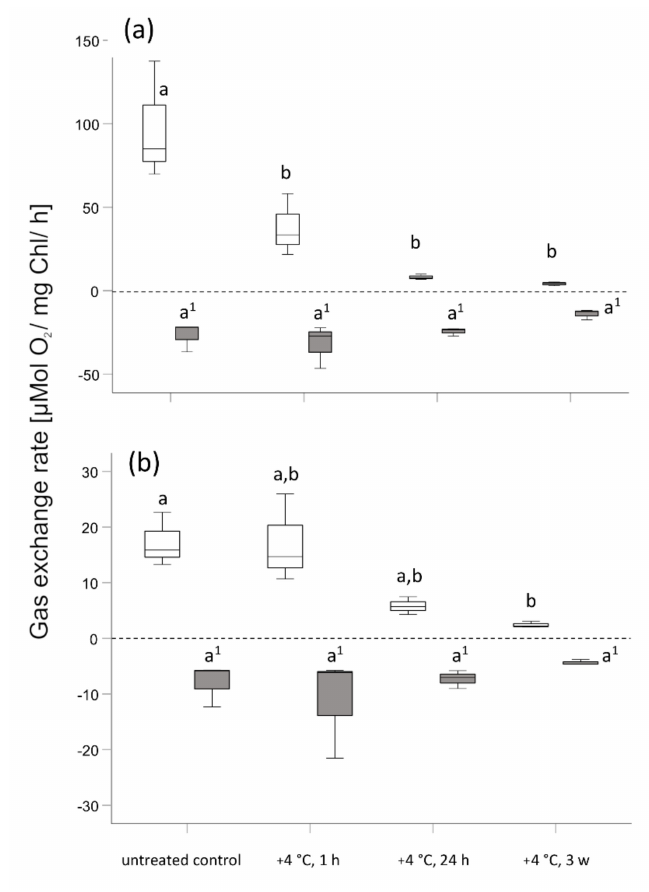
Figure 7. Photosynthetic oxygen production (apparent photosynthesis, open boxplots) and